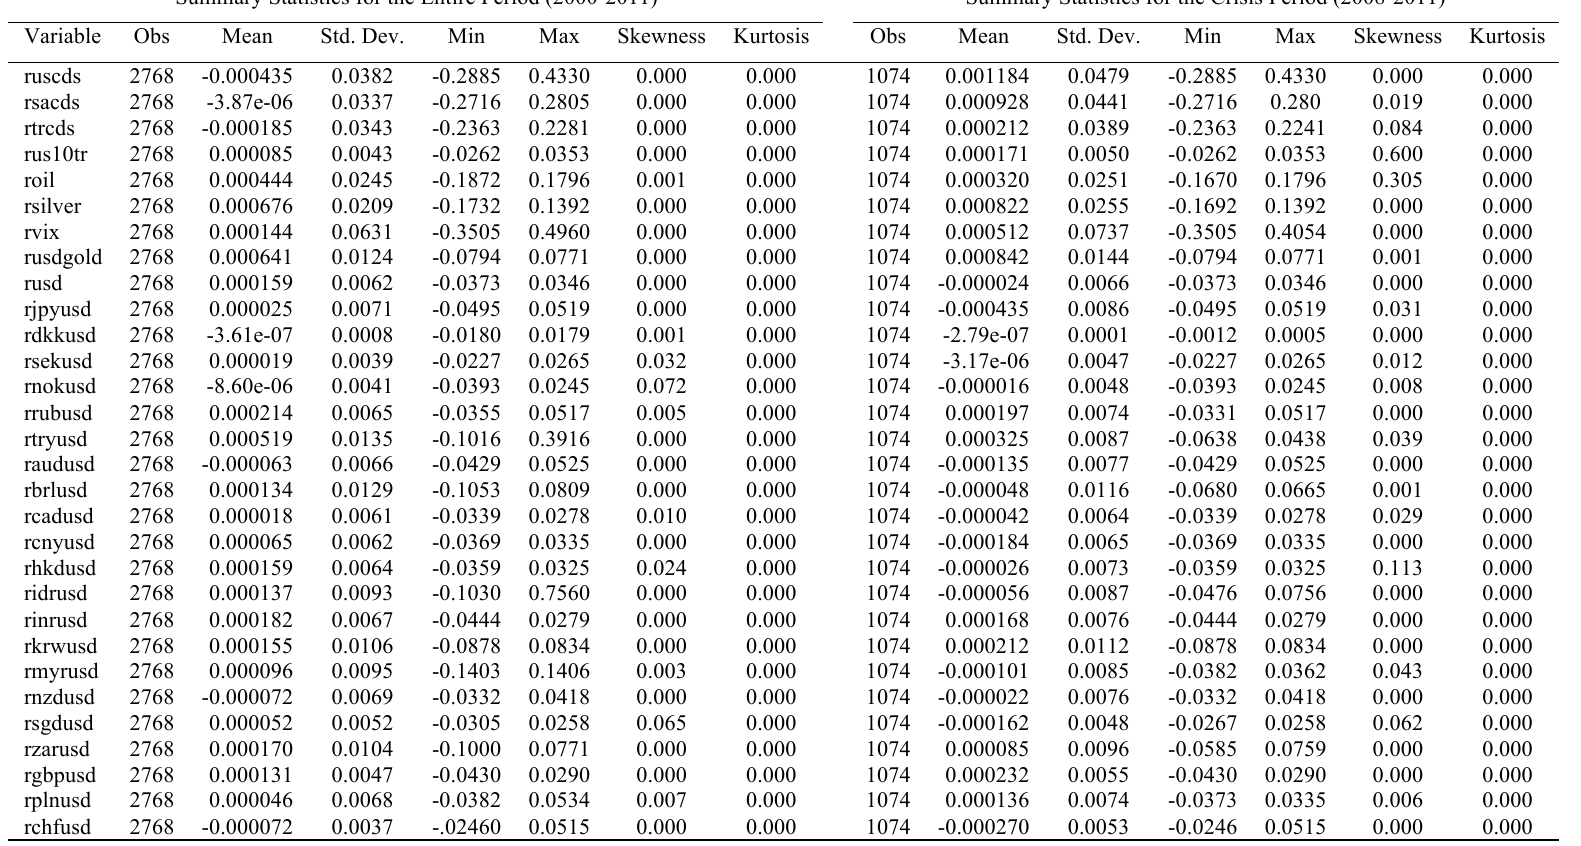
Table 1 Summary